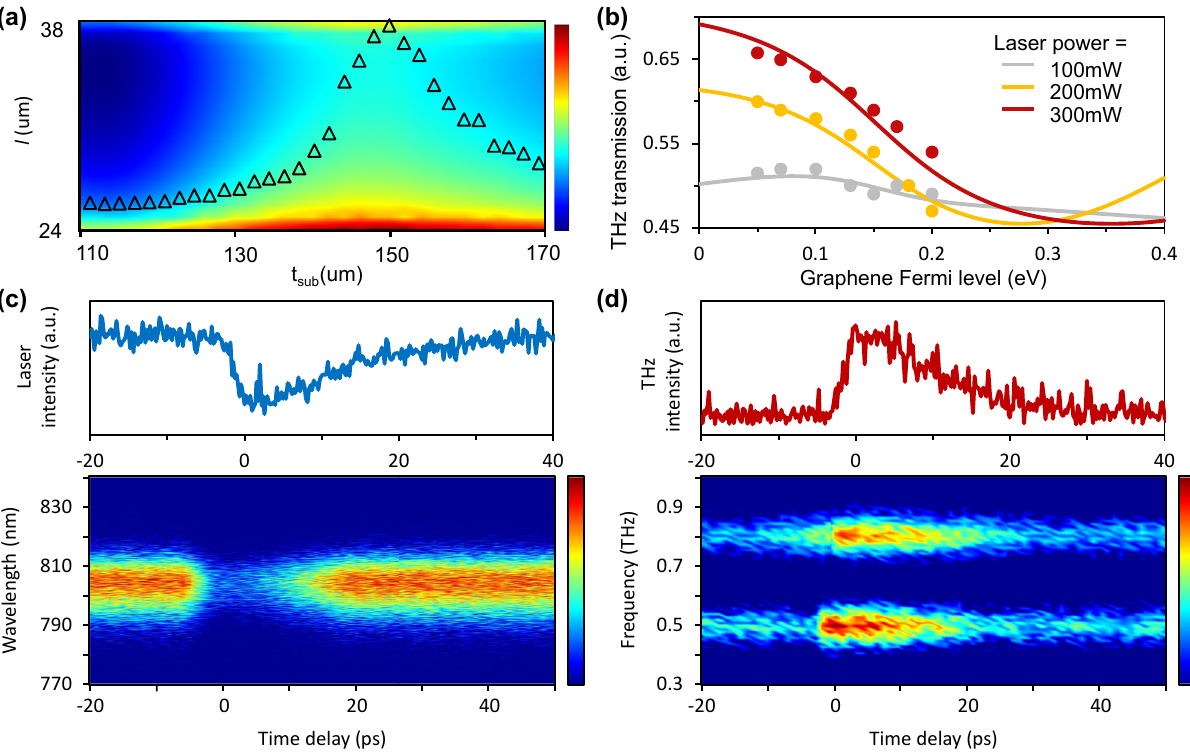
Figure 4: Performance of the optical tuning for terahertz wave. (a) Field confinement in the gap between the rings plotted along the gap (vertical axis) for different t at 0.5 THz. Symbols show the integration of the nonlinear field along l versus substrate thickness (t sub Measured (symbols) and calculated (lines) terahertz transmission, in the GMCs samples with varied graphene Fermi levels. (c) and (d) Ultrafast response of the laser-terahertz interaction, measured by the pumping-probing scheme, under 300 mW laser power. It further verifies the terahertz amplification is derived from laser consumption. The total nonlinear relaxation delay is < 10 ps, suggesting its potential for THz control with tens of GHz bandwidth. Color bar: normalized